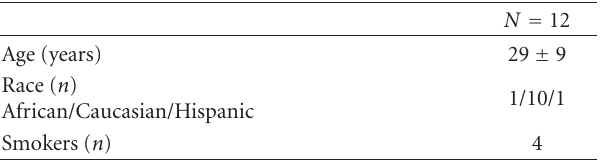
Table 1: Demographic background of female to male transsexuals prior to the initiation of testosterone therapy ( n =